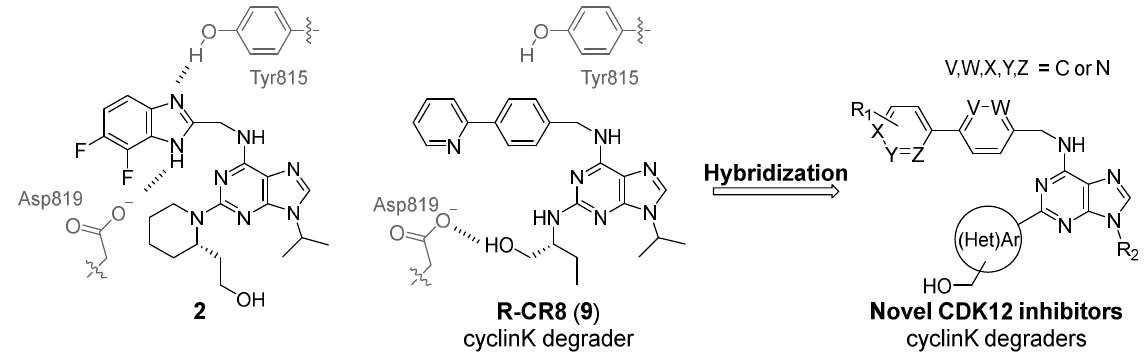
Figure 3. Design of novel purine-scaffold CDK12 inhibitors.